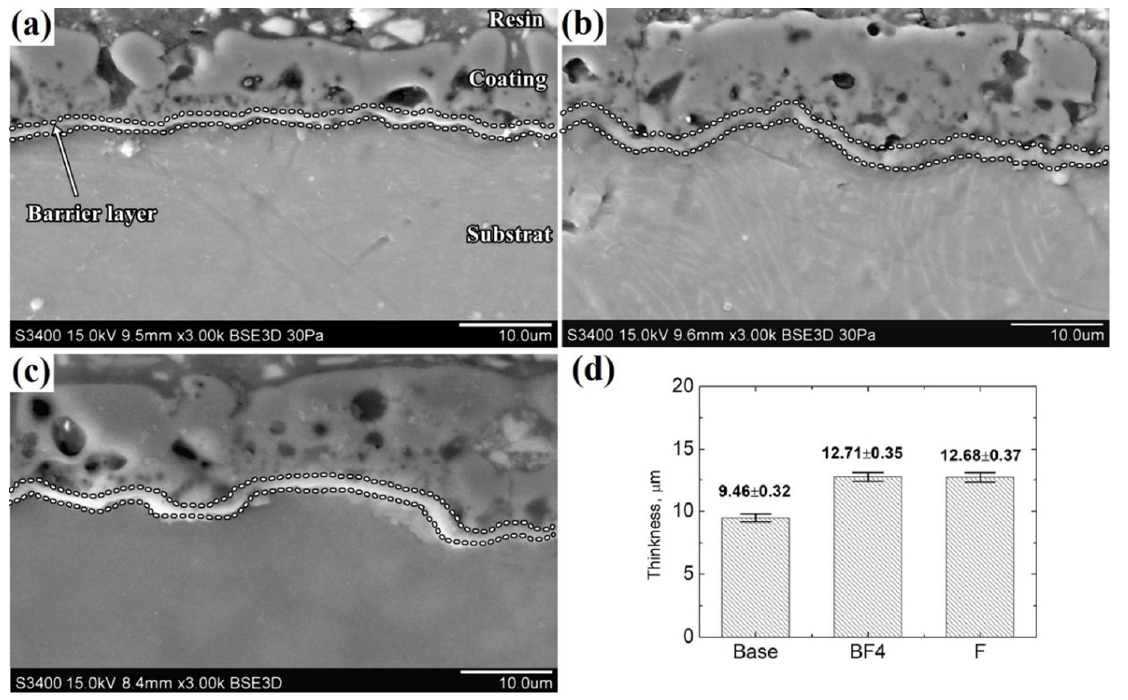
Figure 4. The SEM images of cross-sectional PEO coatings: ( a ) Base; ( b ) BF4; ( c ) F; and ( d ) average values of the thickness of these coatings. (The dashed lines were added to make the inner layer more visible).